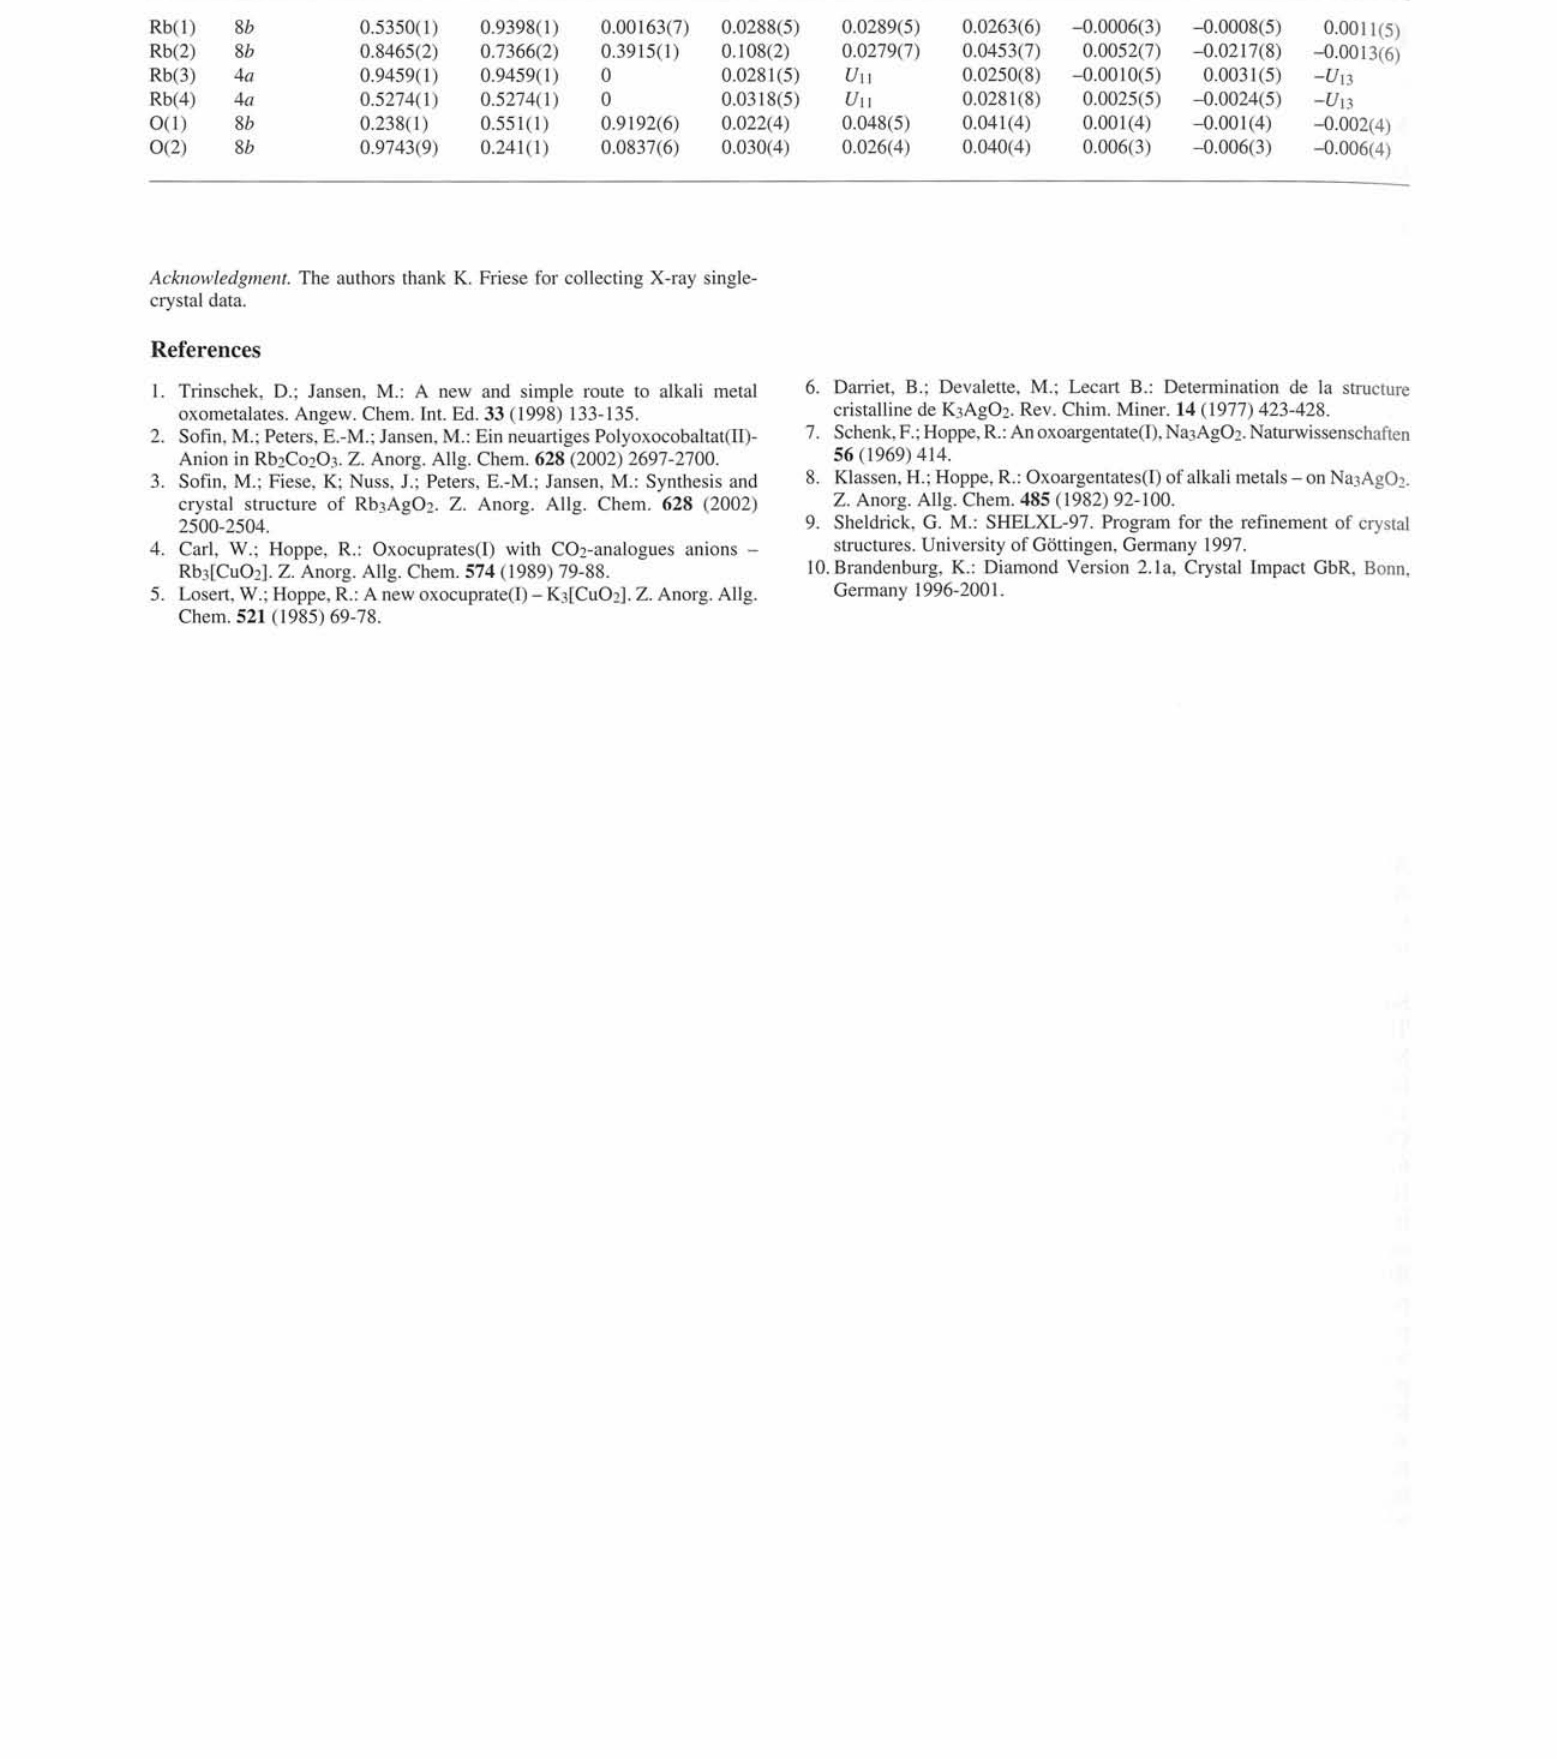
Table 3. Atomic coordinates and displacement parameters (in